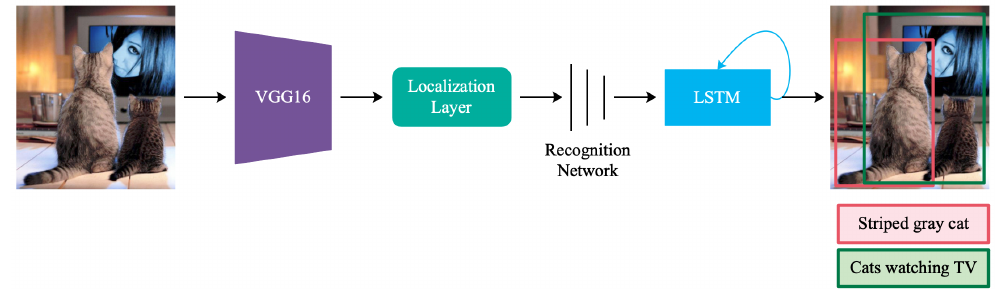
Figure 2. A brief schema of DenseCap.An input image is first processed by the VGG16 [12]. The Localization Layer proposes regions and uses bilinear interpolation to smoothly extract a batch of corresponding activations. After that, these regions are processed using a fully-connected recognition network and described with an LSTM model.